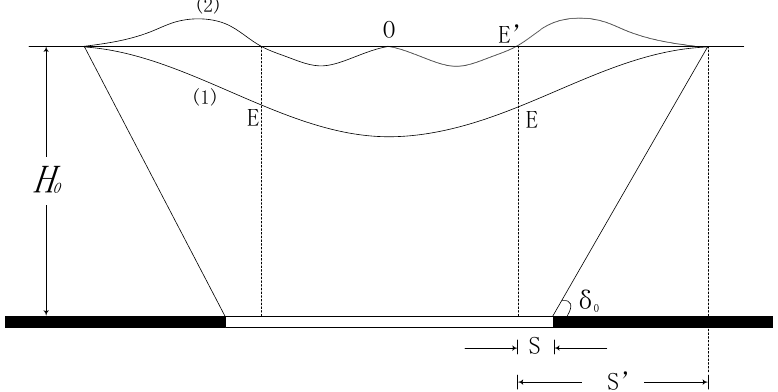
Figure 2. Subsidence and curvature curves. Curve ( 1 ) represents the distribution law of surface subsidence W ( x ) caused by mining activities. Curve ( 2 ) represents the distribution law of the curvature K ( x ) . It is also the second derivative of the subsidence